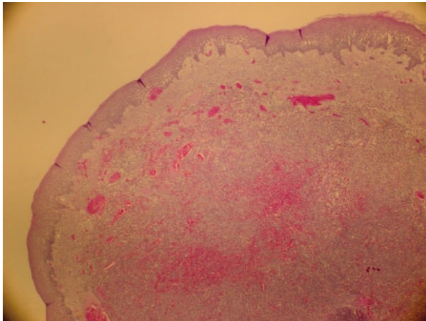
Figure 4: (I.I 200x). CD34 immunoreactivity is seen in the neoplas- tic spindle